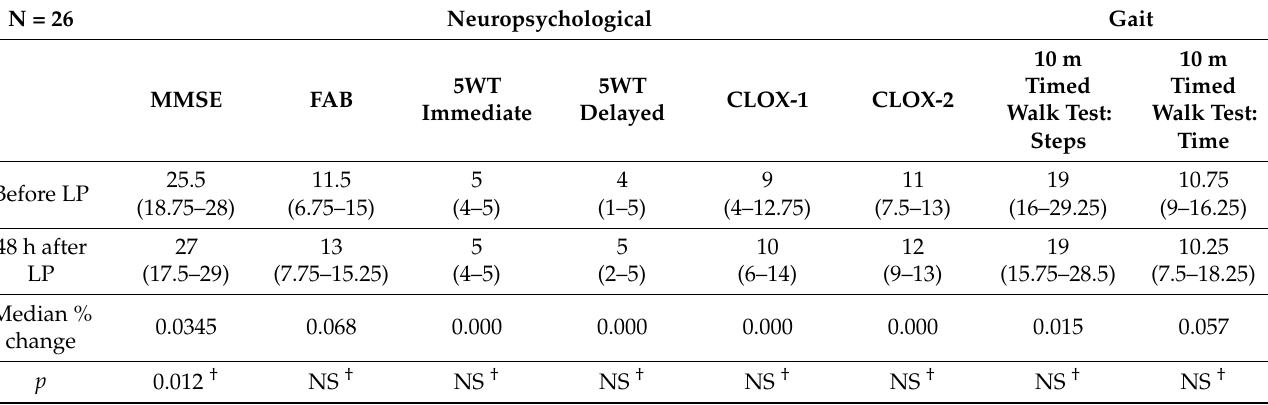
Table 4. Neuropsychological and gait data of tap test